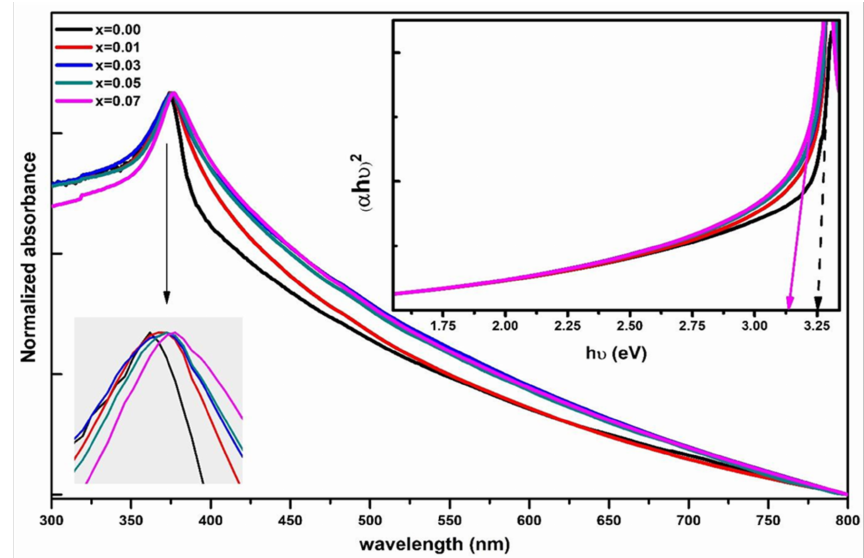
Figure 4. UV–visible absorbance spectra of Zn 1 − x Li x O nanostructured samples. Inset showed the Tauc plots of the absorbance spectra of Zn 1 − x Li x O nanostructured samples.